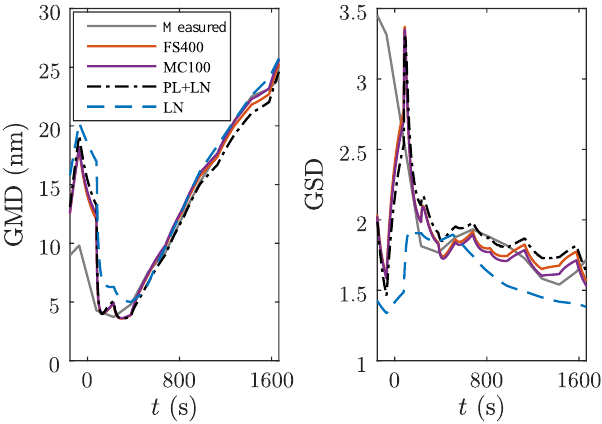
Figure 8. Geometric mean diameter (GMD) and geometric stan- dard deviation (GSD) of the nucleation mode in the chamber event, obtained through inverse modeling, using different